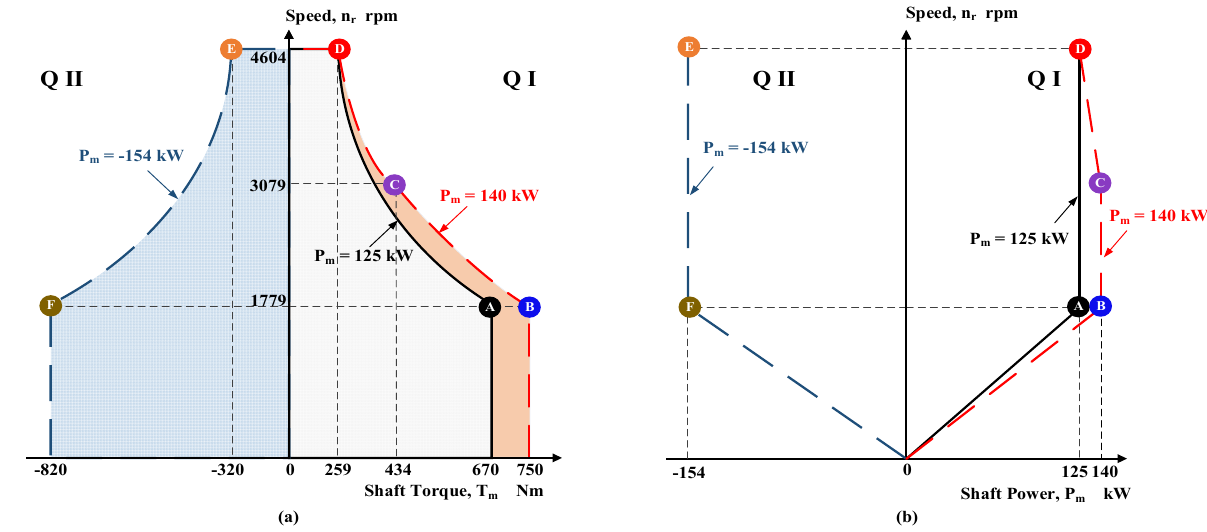
Figure 2. Operating characteristics of the traction motor drive for forward motion. ( a ) Speed/torque characteristics; ( b ) speed/shaft power. characteristics; ( b ) speed/shaft